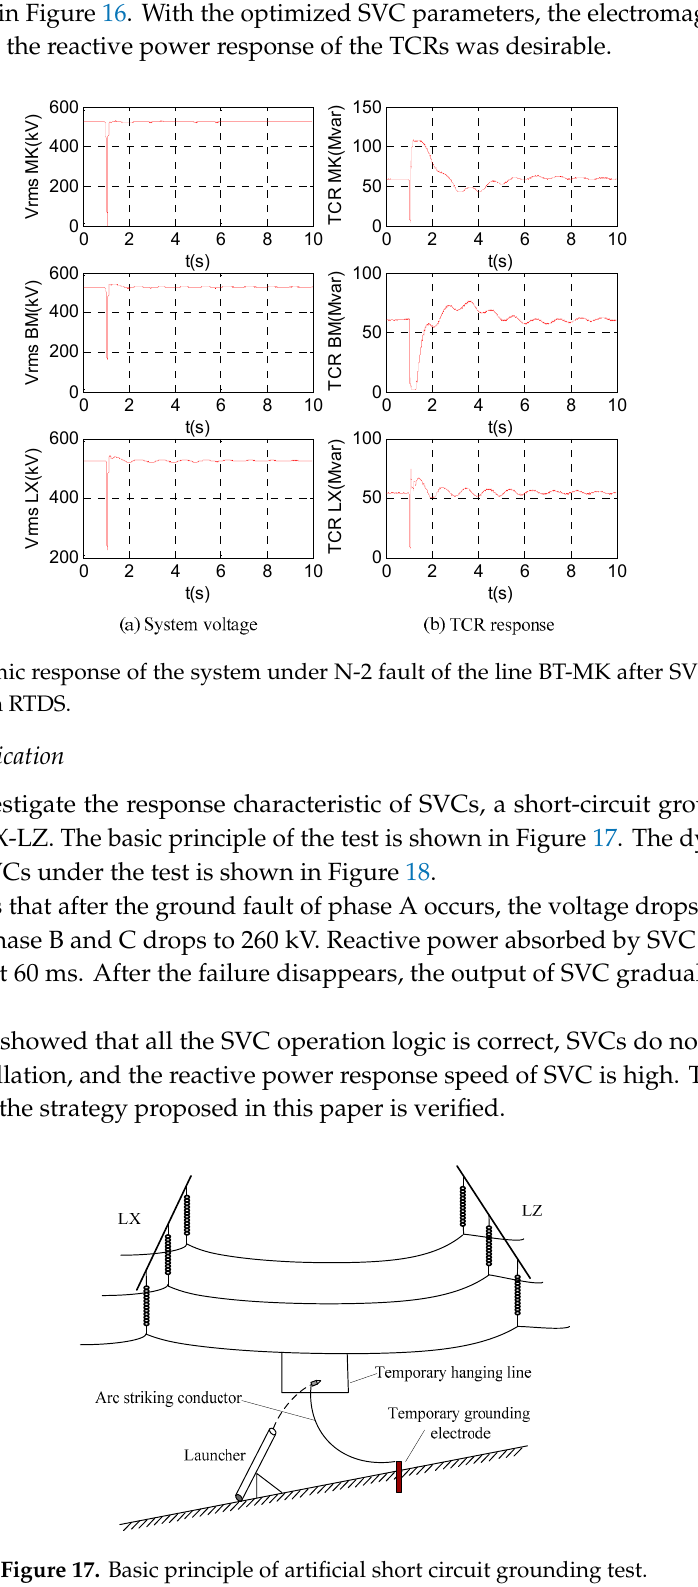
Figure 17. Basic principle of artificial short circuit grounding test.